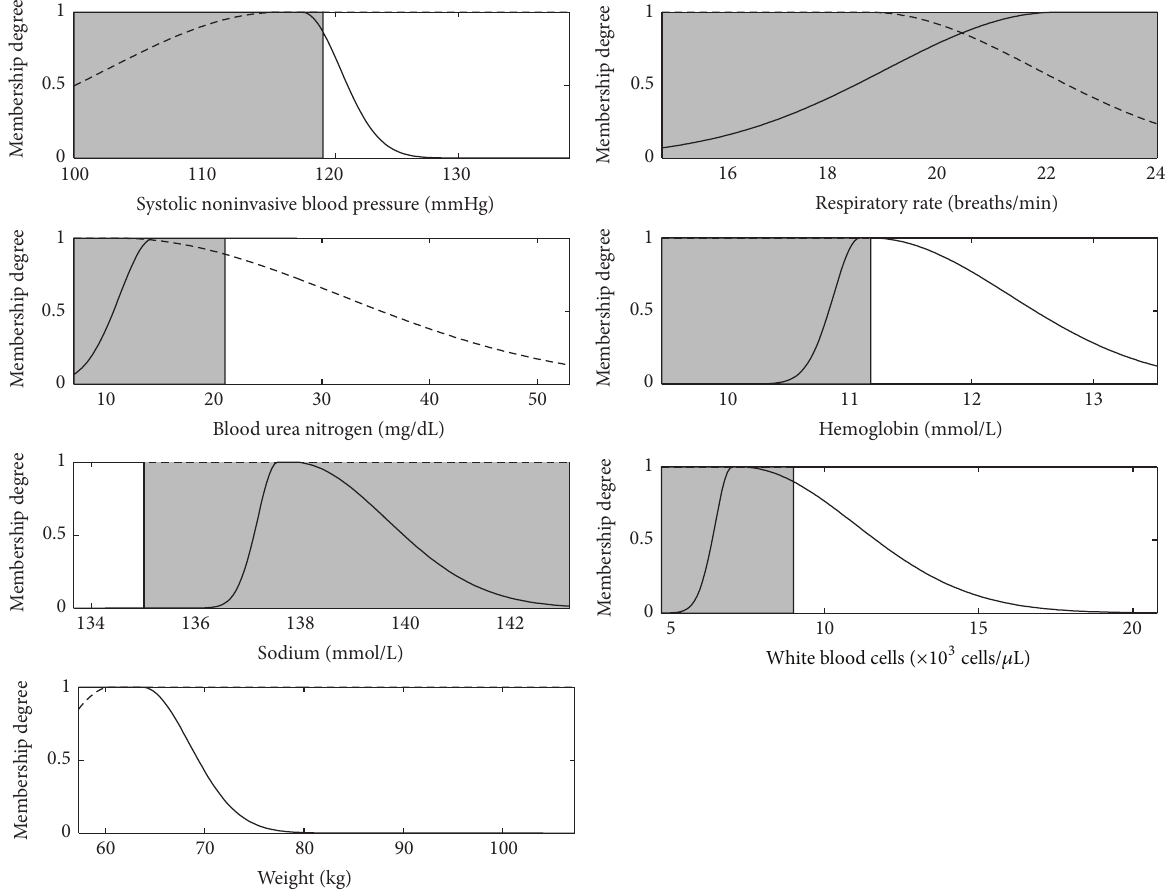
Figure 5: Membership functions obtained for assessing severely depressed LVEF. Lower and upper bounds accepted for normal values ranges are also depicted (grey zone). The solid-lined cluster corresponds to the antecedents of Rule 1 ( 𝐴 𝑖,1 ) and the dash-lined cluster corresponds to those of Rule 2 ( 𝐴 𝑖,2